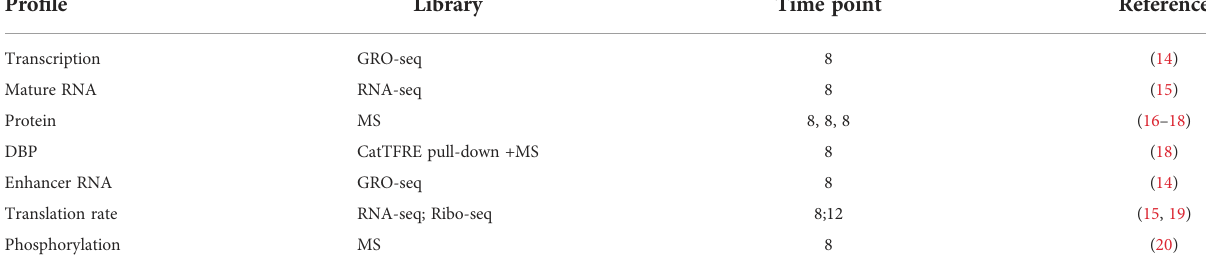
TABLE 1 Omics data sets across